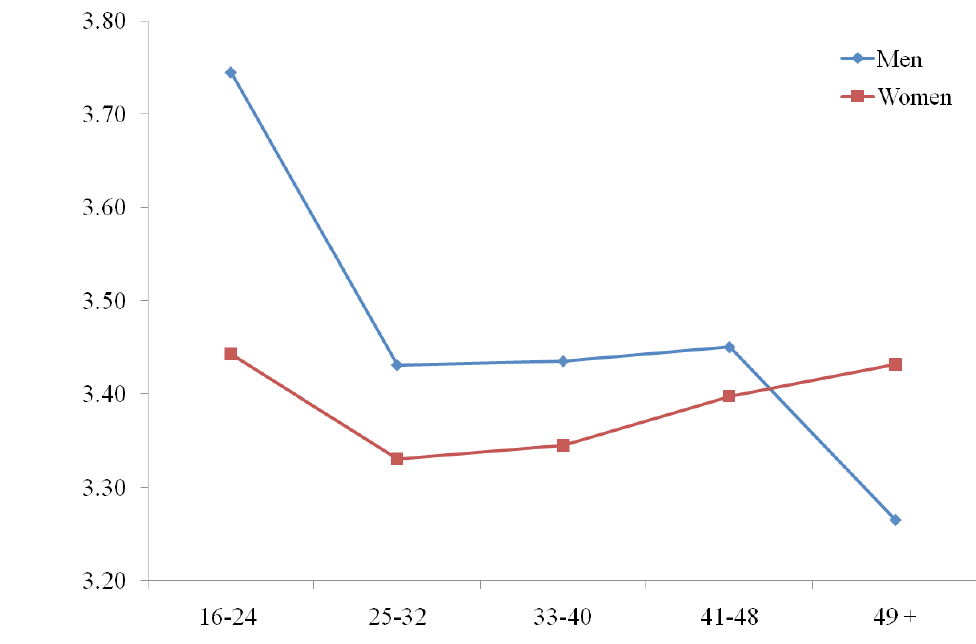
Figure 1 . Mean evaluation of past experience with